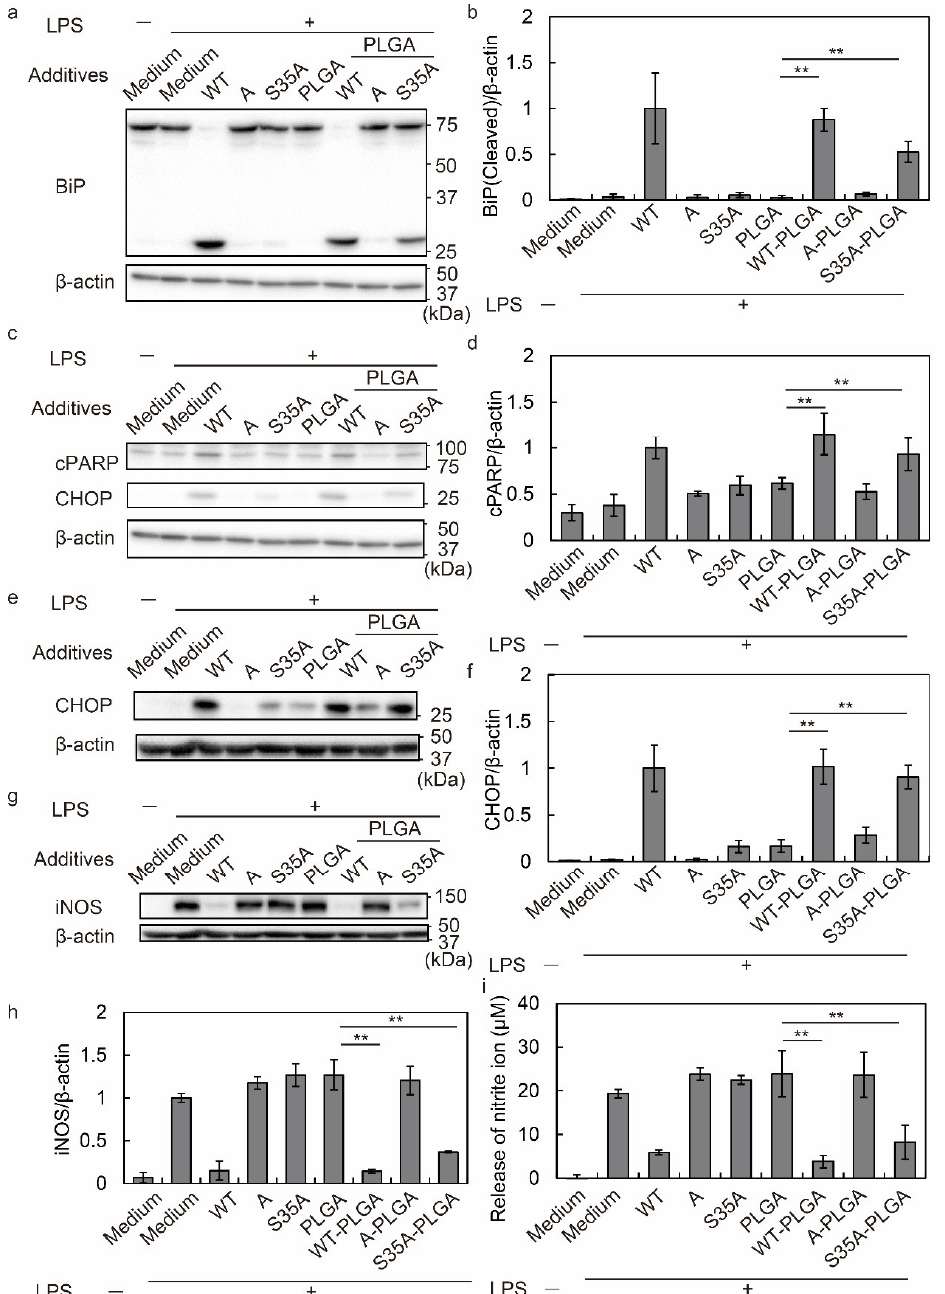
Figure 3. Induction of ER stress and anti-inflammatory effect by SubAB-PLGA NPs on macrophages. ( a – h ) J774.1 cells were treated with or without LPS (100 ng/mL) in the presence or absence of 5 μg/mL toxins and 20 μg/mL PLGA NPs for 3, 8, and 20 h. After incubation, the cells were lysed in SDS sample buffer and subjected to Western blotting. ( a ) Evaluation of BiP cleavage at 3 h by Western blot analysis. ( b ) Quantification of BiP cleavage by densitometry. ( c ) Evaluation of cleaved PARP (cPARP) and CHOP expression at 8 h by Western blot analysis. ( d ) Quantification of PARP cleavage by densitometry. ( e ) Evaluation of CHOP expression at 20 h by Western blot analysis. ( f ) Quantification of CHOP expression by densitometry. ( g ) Evaluation of iNOS expression at 20 h by Western blot analysis. ( h ) Quantification of iNOS expression by densitometry. ( i ) Quantification of nitrite production by the Griess assay. Data are expressed as means ± S.D. ( n = 3). Statistical analyses were performed using Student’s t -test. ** p <